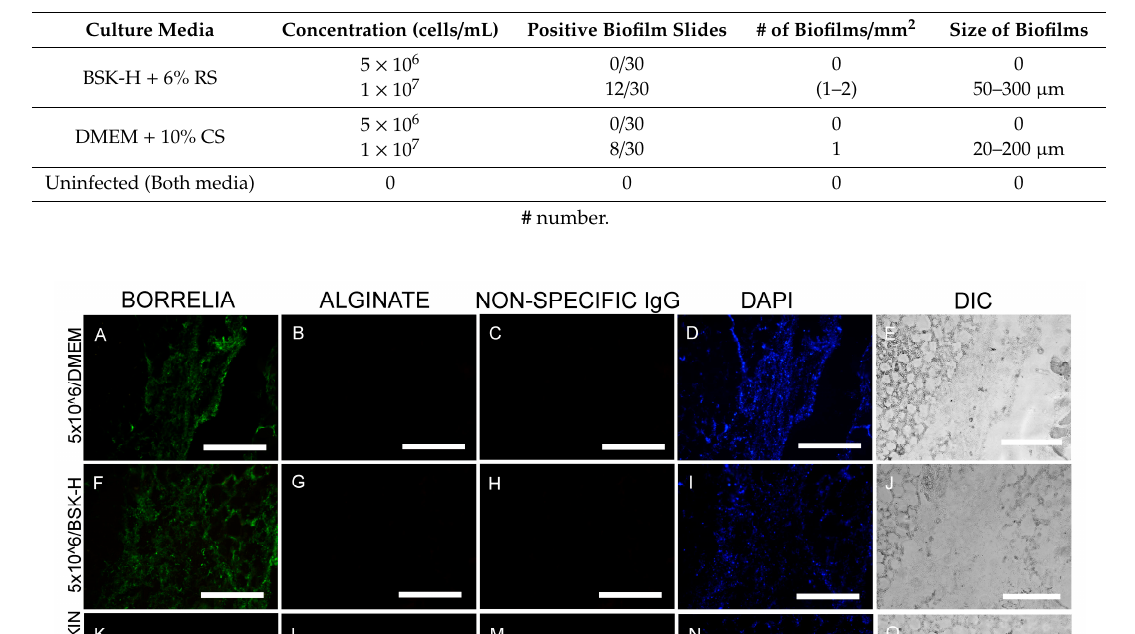
Table 2. Quantitative summary of biofilms found in B. burgdorferi -inoculated murine skin biopsies and cultured in BSK-H + 6% RS and DMEM + 10% CS.